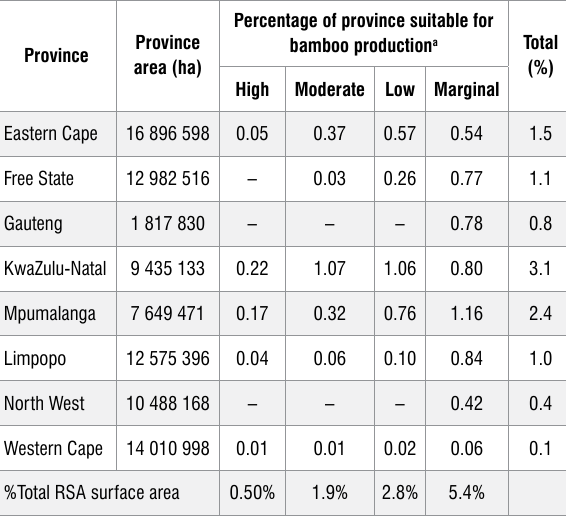
Potential bamboo production areas in South Africa 13